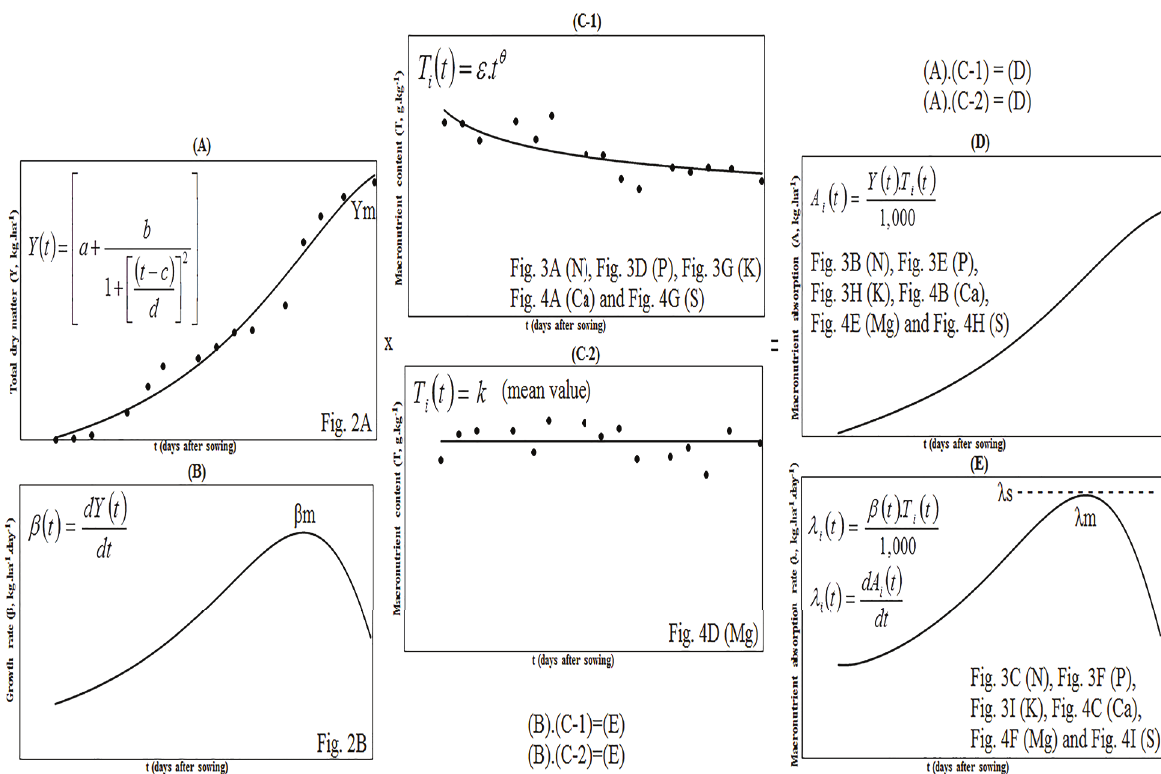
Figure 1 - Basic hypothesis of the macronutrient absorption model: (a) crop growth (Y, kg[dry matter].ha -1 ), (b) crop growth rate (β, kg[dry matter].ha -1 .day -1 ) as a function of time ( t , day - DAS), (c) macronutrient content (T, kg[nutrient].kg[dry matter] -1 ) (c-1 or c-2), (d) temporal variation of macronutrient absorption (A, kg[nutrient].ha -1 ), (e) crop macronutrient absorption rate (λ, kg[nutrient].ha -1 .day -1 ) and soil macronutrient availability rate off er (λs, kg[nutrient].ha -1 .day - 1 - dashed line represents the soil macronutrient availability rate off er), λ m corresponding to the maximum crop macronutrient absorption rate demand (kg[nutrient].ha -1 .day -1 ) and βm maximum crop growth rate (kg[dry matter].ha -1 .day -1 ) related to the corn productivity